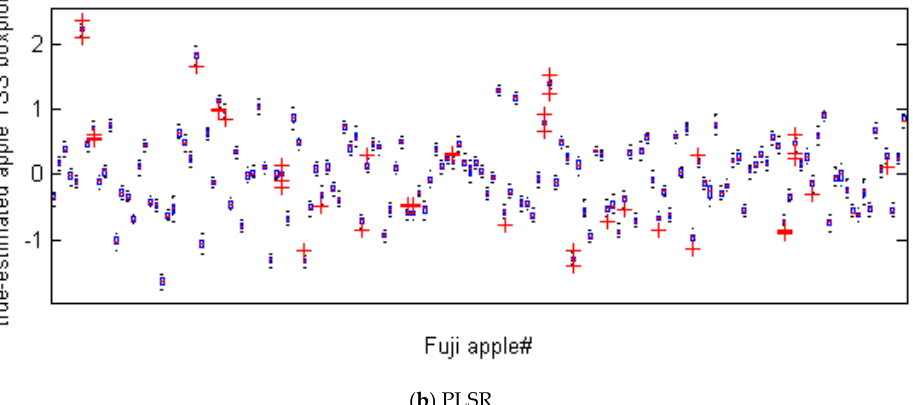
Figure 6. Box diagrams representing difference between the true and the predicted values of TSS in 500 replications. ( a ) ANN-ICA method, ( b ) PLSR method. 500 replications. ( a ) ANN-ICA method, ( b ) PLSR